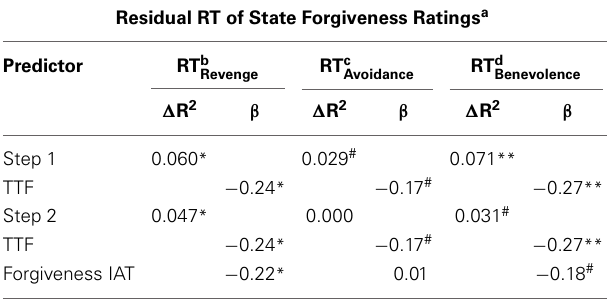
Table 4 | Hierarchical Multiple Regression Analyses Predicting Response Time by Implicit and Explicit